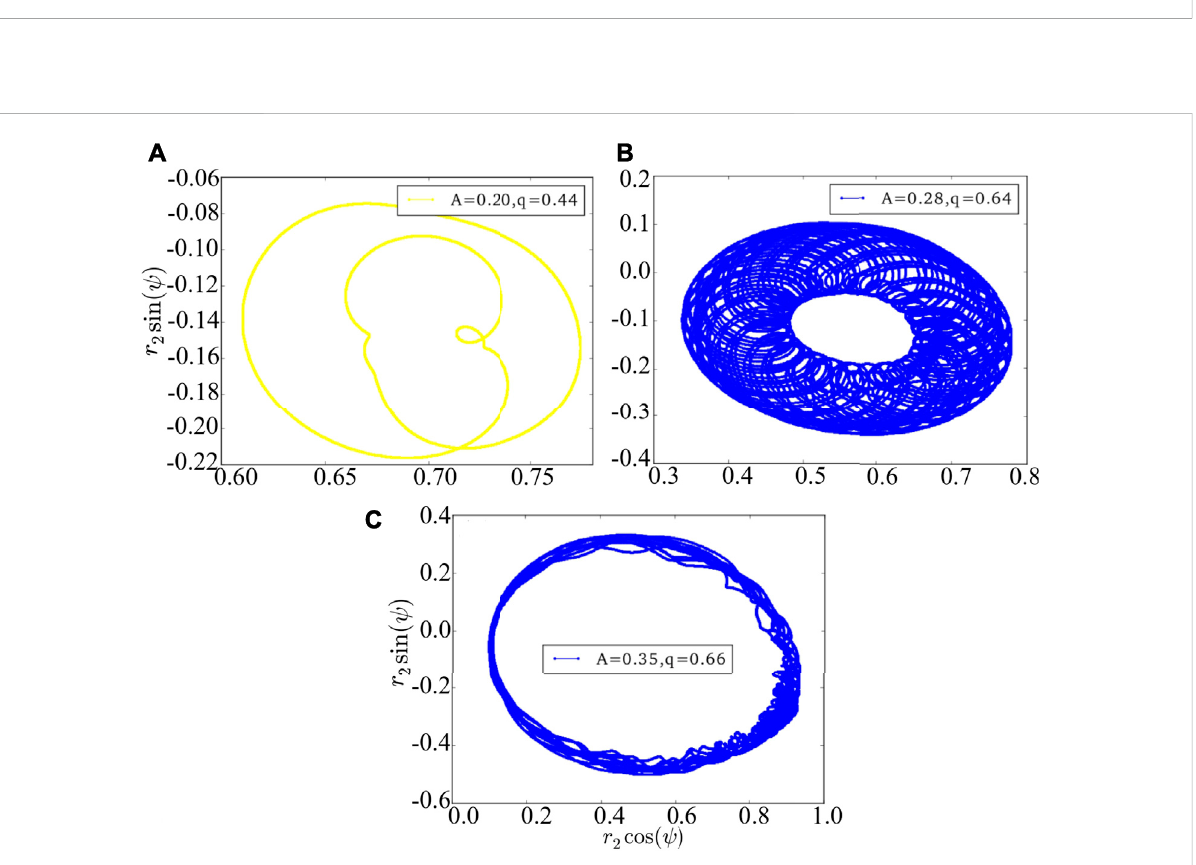
The phase portrait of the original dynamics (1). (A) is periodic chimera, and (B,C) are quasi-periodic chimeras. The realizations vary depending crucially on the initial conditions, perturbations and parameter values. Here we use arbitrary values of parameters A = 0.20 and q = 0.44 in (A) , A = 0.28 and q = 0.64 in (B) , and A = 0.35 and q = 0.66 in (C)